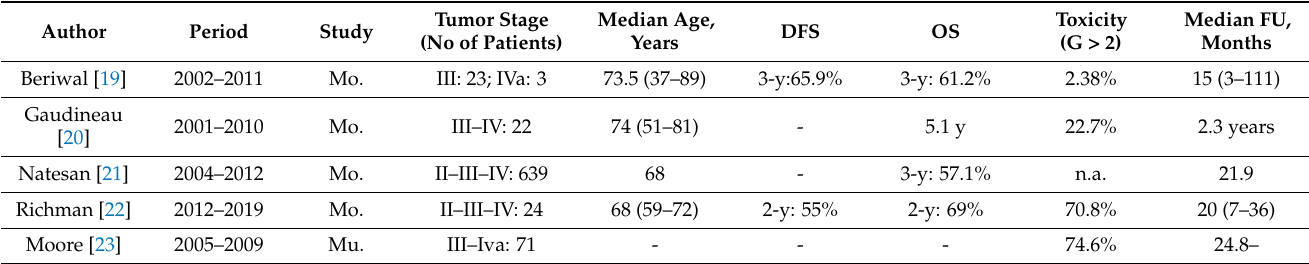
Table 1. Neoadjuvant